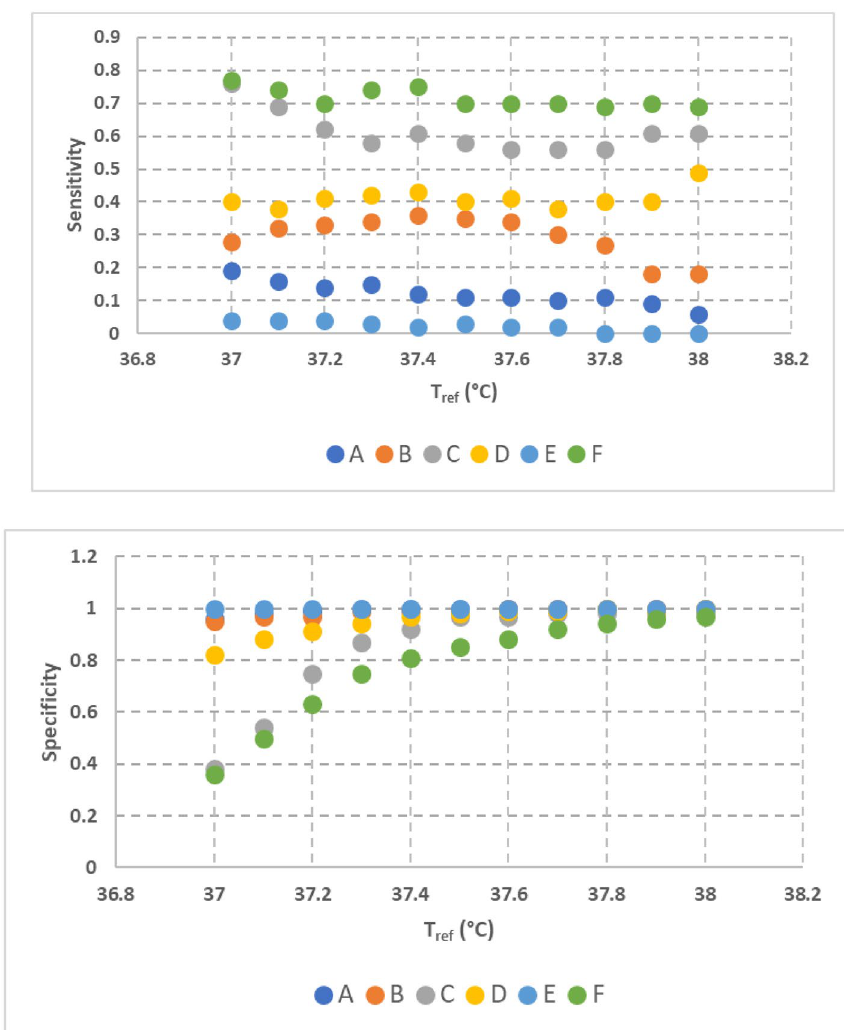
Figure 4. Sensitivity and specificity of all NCIT models obtained from Trial #1